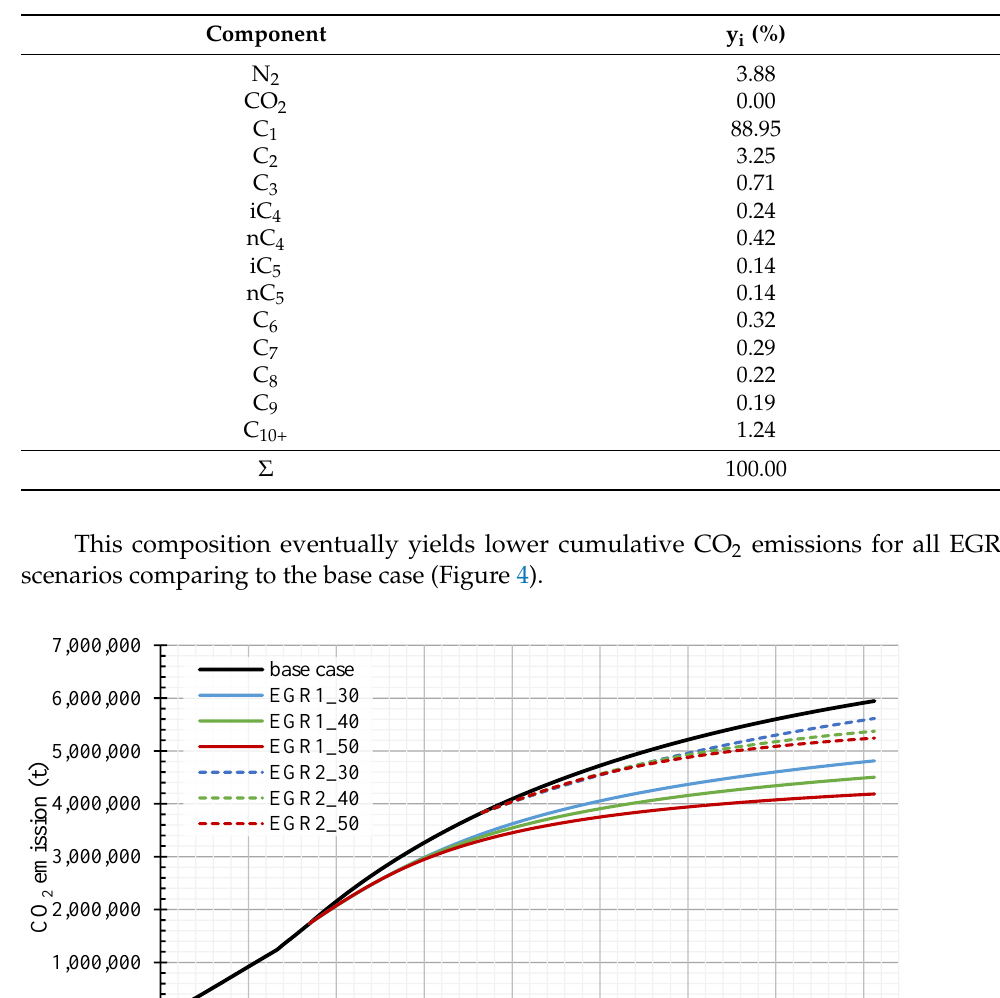
Table 3. Normalized composition of the gas to be used as fuel.